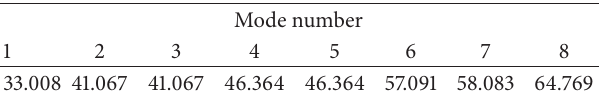
Table 5: Frequency parameters of an elastically supported shallow